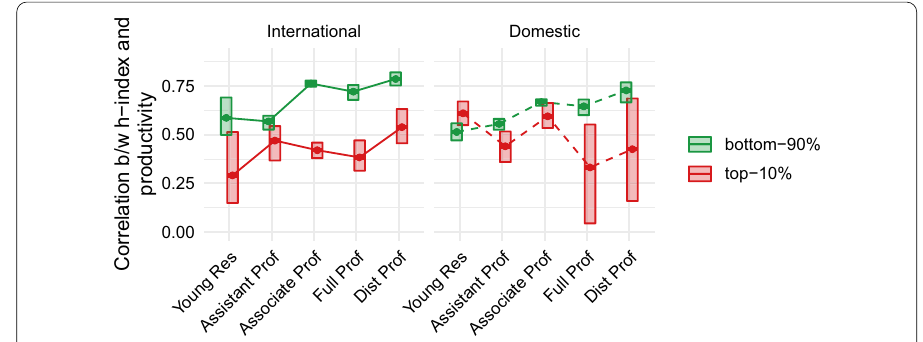
Fig. 16 Highly-mobile researchers: productivity and impact. Correlation of publications and h-index by migration type and career stage. Highly mobile authors in red, regular authors in